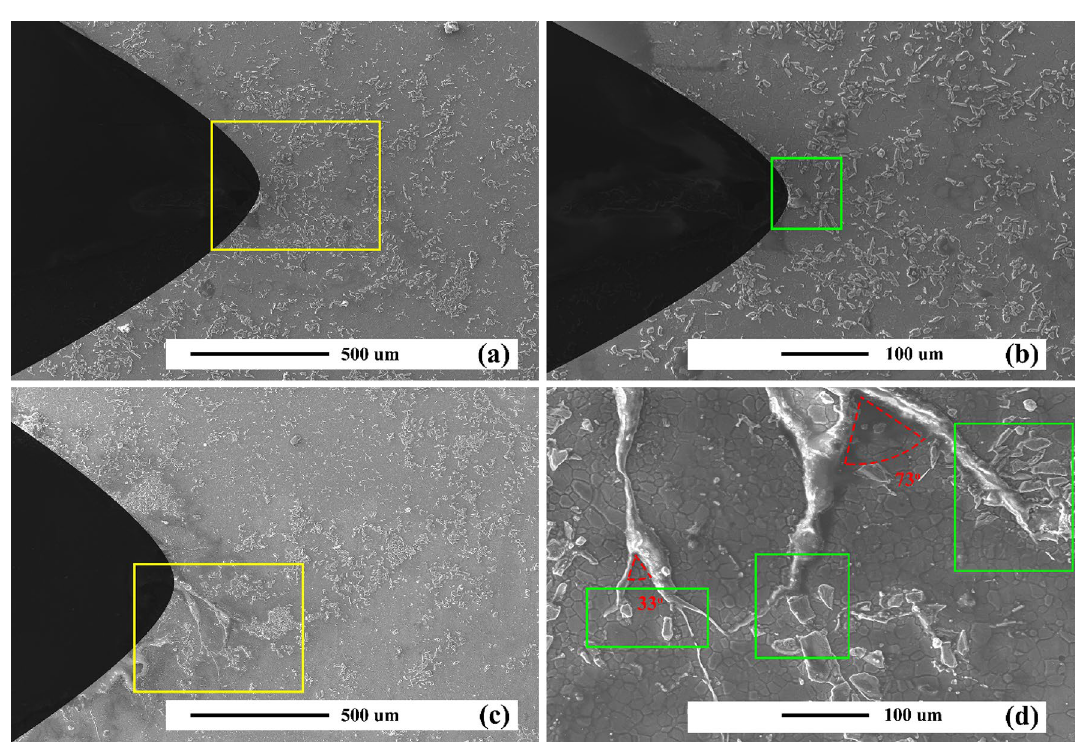
Figure 21. SEM micrograph of as-cast AZ31/10%SiC after thermal cycles at 350 °C ( a ) and ( b ) 300 thermal cycles, and ( c ) and ( d ) 900 thermal